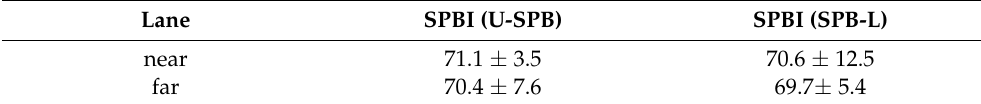
Table 9. SPBI comparison for U-SPB and SPB standard in V. Values in